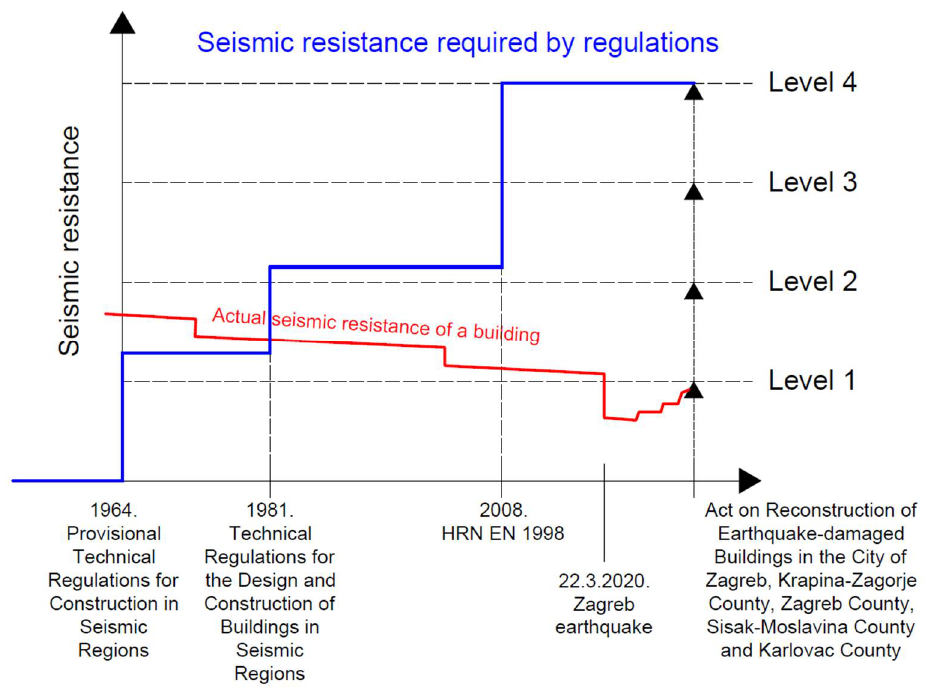
Figure 4. Schematic representation of the reconstruction levels in relation to the actual level of the building’s seismic resistance capacity.